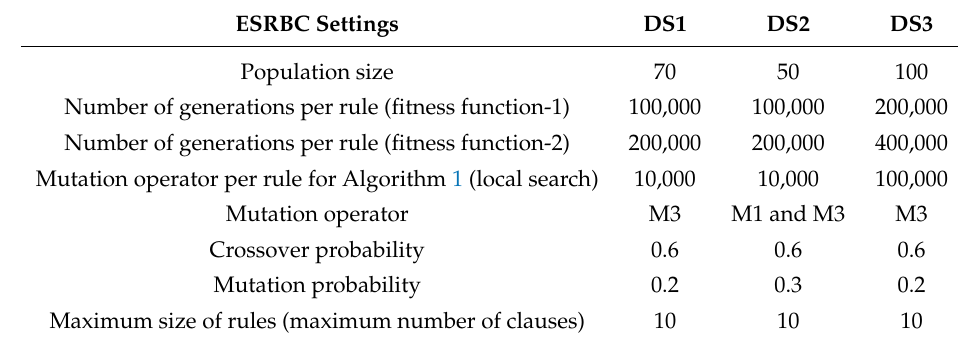
Table 1. Settings given to run the evolutionary method (ESRBC) to build rule-based classifiers for each dataset.